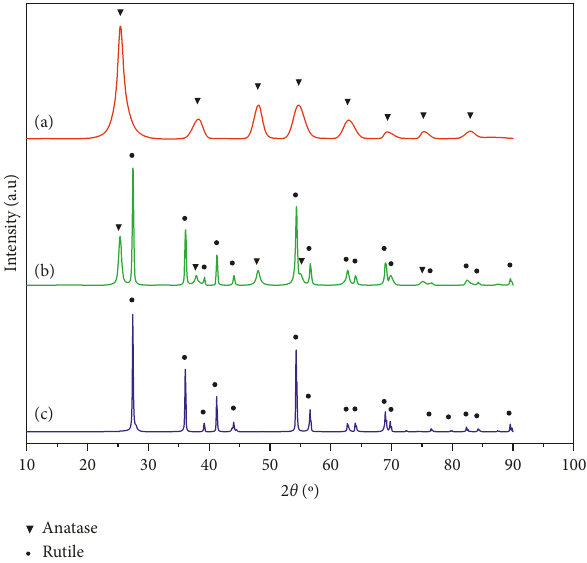
Figure 6: X-ray diffraction spectra for TiO 2 -coated MWCNTs with II coating cycles and calcined at (a) 500